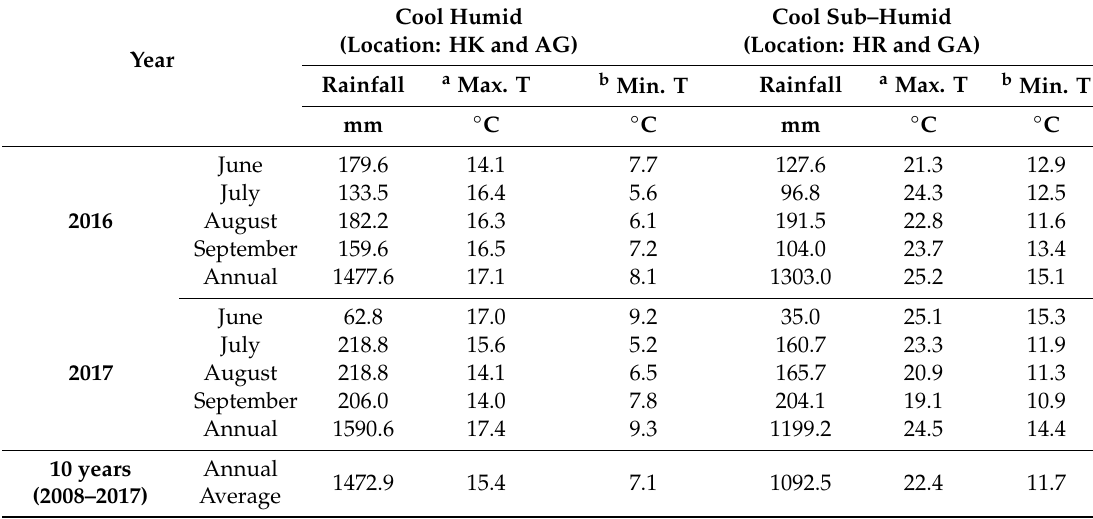
Table 1. Annual average rainfall and the mean maximum and minimum temperatures during the study period and long-term average. Cool Humid Cool Sub–Humid (Location: HK and AG) (Location: HR and GA) Year Rainfall a Max. T b Min. T Rainfall a Max. T b Min. T mm ◦ C ◦ C ◦ C ◦ C